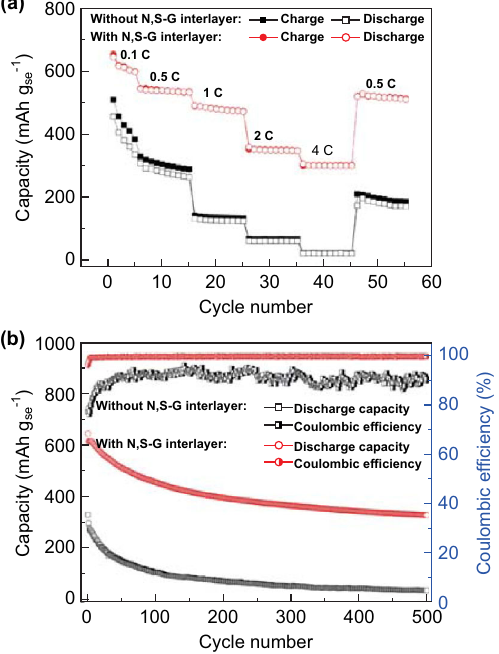
Fig. 6 a Rate performance of Li–Se cells with and without N,S-G interlayer. b Long-term cycling performance of Li–Se cells with and without N,S-G